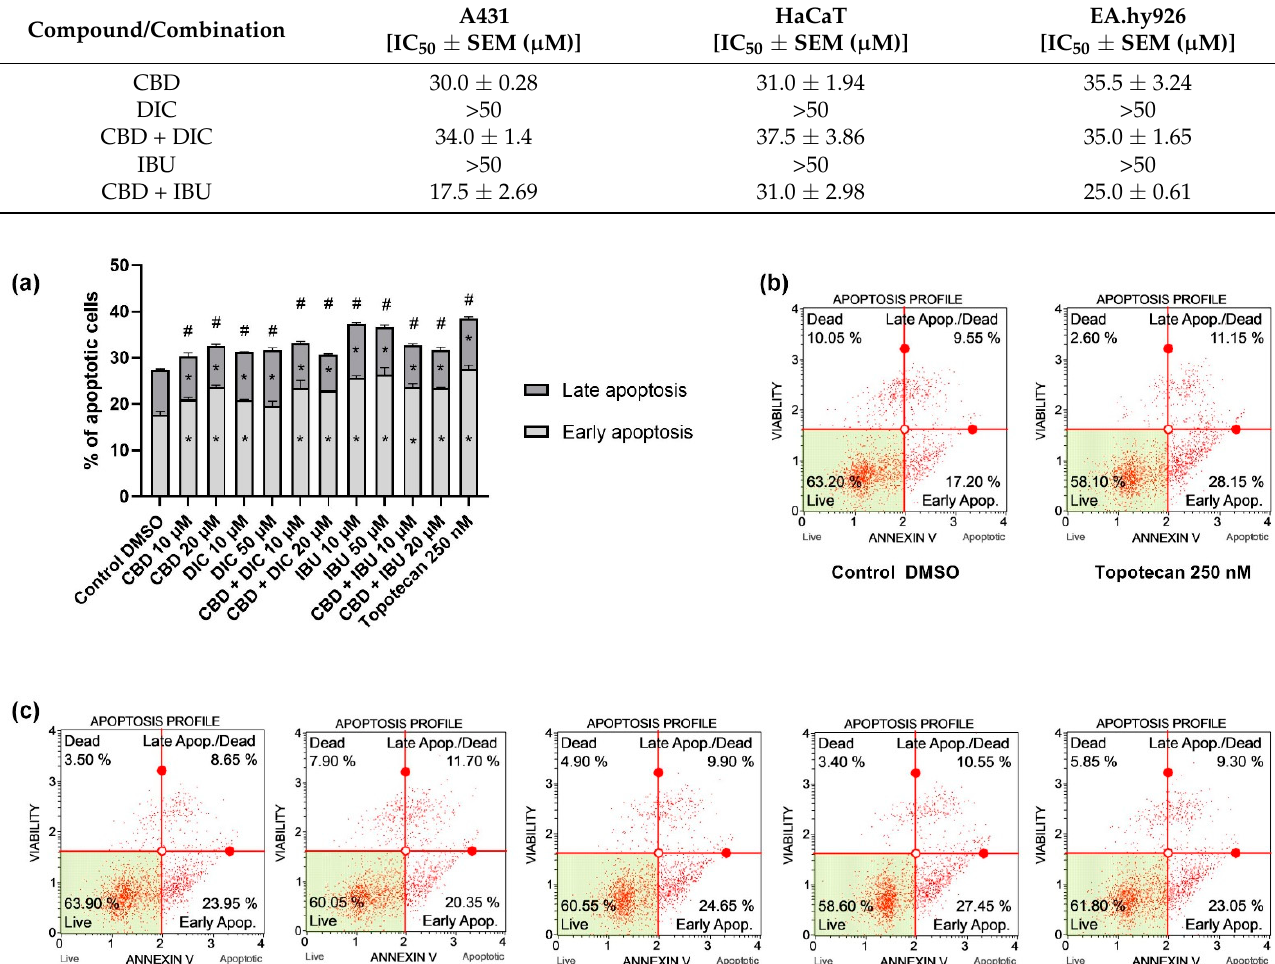
Table 1. The IC 50 values for a 24 h treatment of A431, HaCaT and EA.hy926 cell lines with CBD, DIC, the combination of CBD + DIC, IBU and the combination of CBD + IBU.